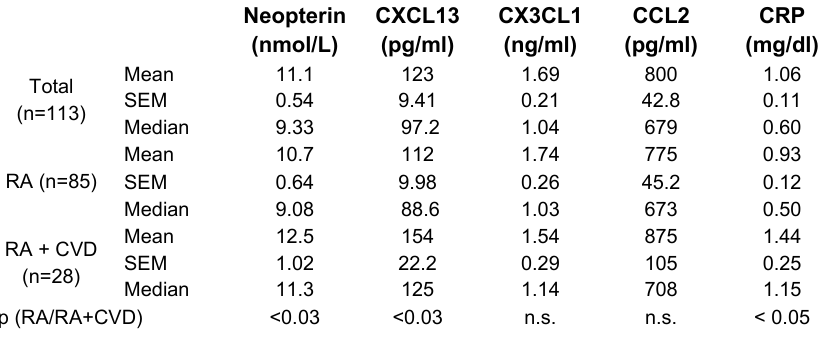
Table 2 : Concentrations of neopterin and chemokines in patients with rheumatoid arthritis (RA) and RA plus car- diovascular disease (RA+CVD). Mean = arithmetic mean value, S E M = standard error of mean, Median = geo- metric mean value, p = significance, ns = not significant.